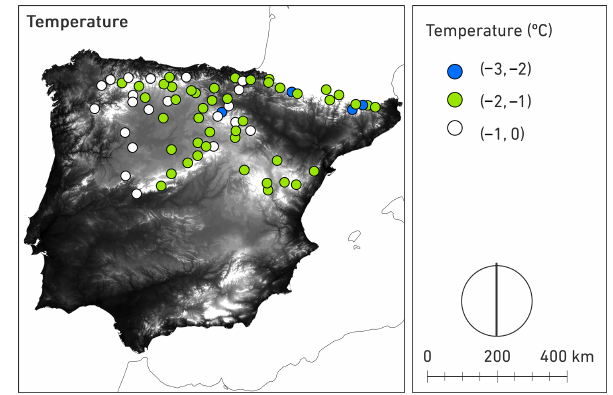
Figure 10. Average station temperature during 1h snowfall events. The colours represent temperature ranges with different (minimum, maximum) temperatures as indicated in the